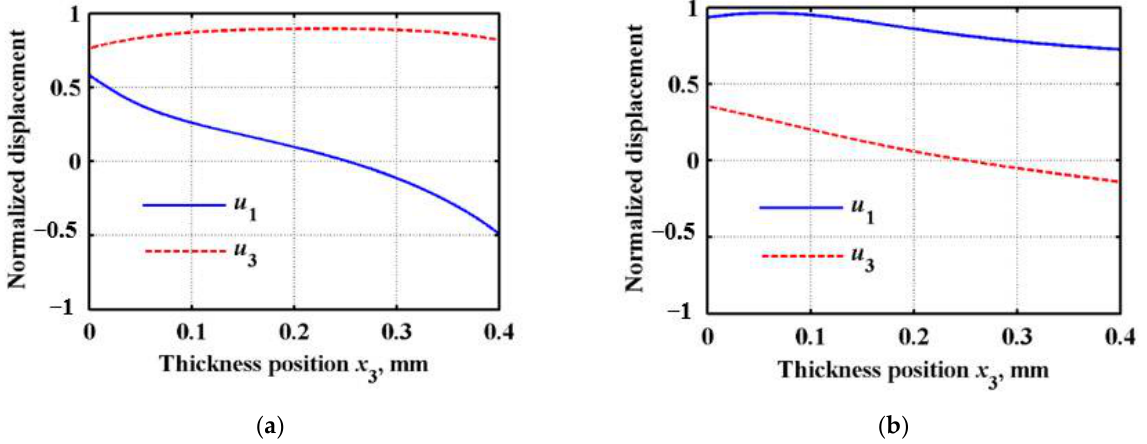
Figure 6. Lamb wave displacement distribution curve in FGM sandwich plate. ( a ) A 0 mode; ( b ) S 0 mode.